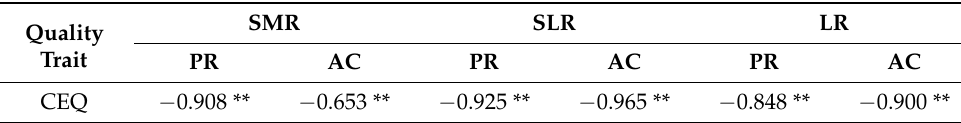
Table 4. Correlation of the CEQ with AC and PR 1 .